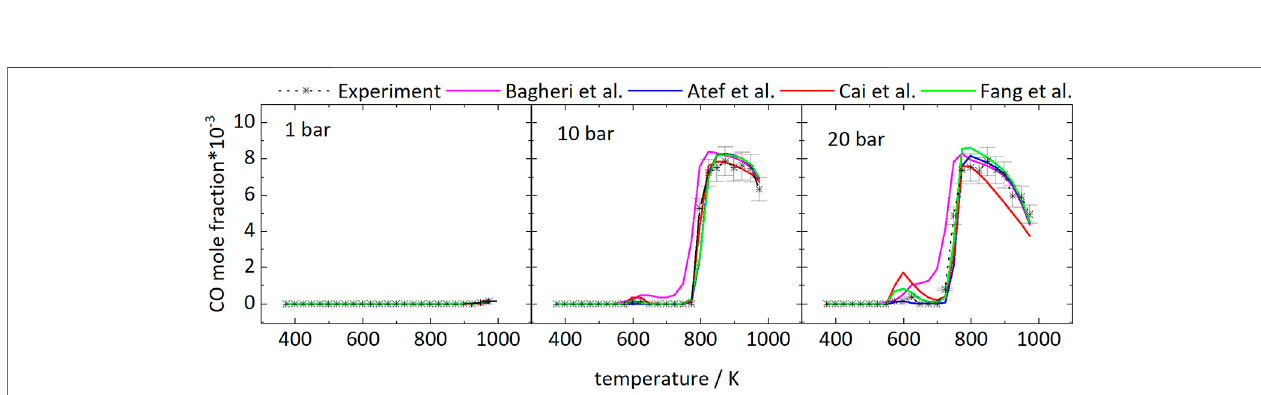
FIGURE2| MolefractionsofCOvs.reactor-temperatureat1,10,and20 bar.Dashedlineswithsymbolsandsolidlinescorrespondtoexperimentalandmodeling results,